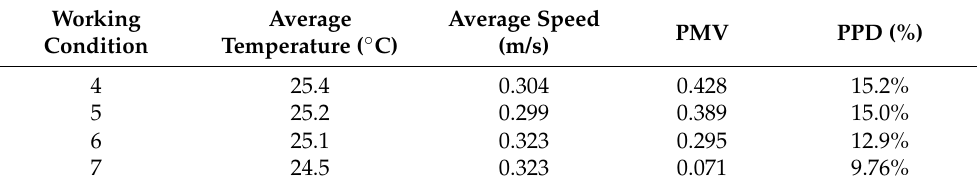
Table 9. Summary of the average value of calculation parameters in the working area under different working